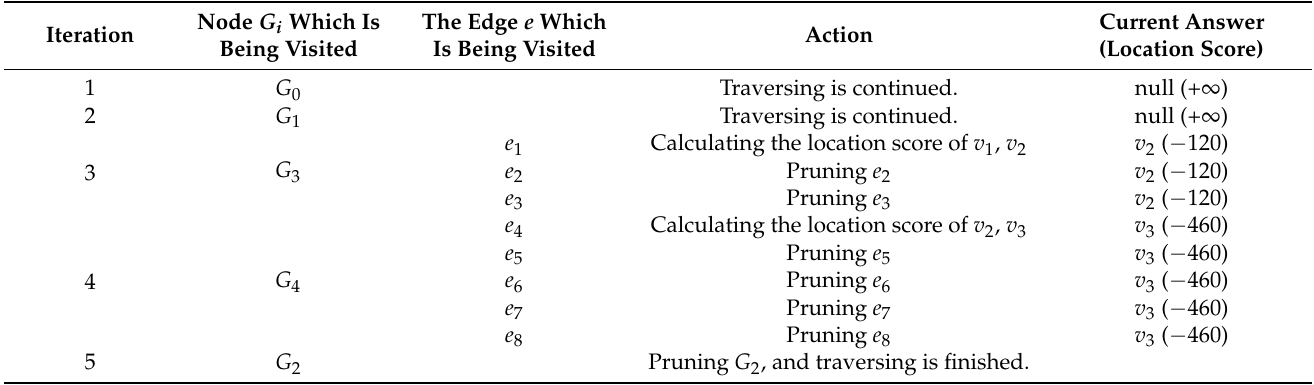
Table A15. Traversal of the G +